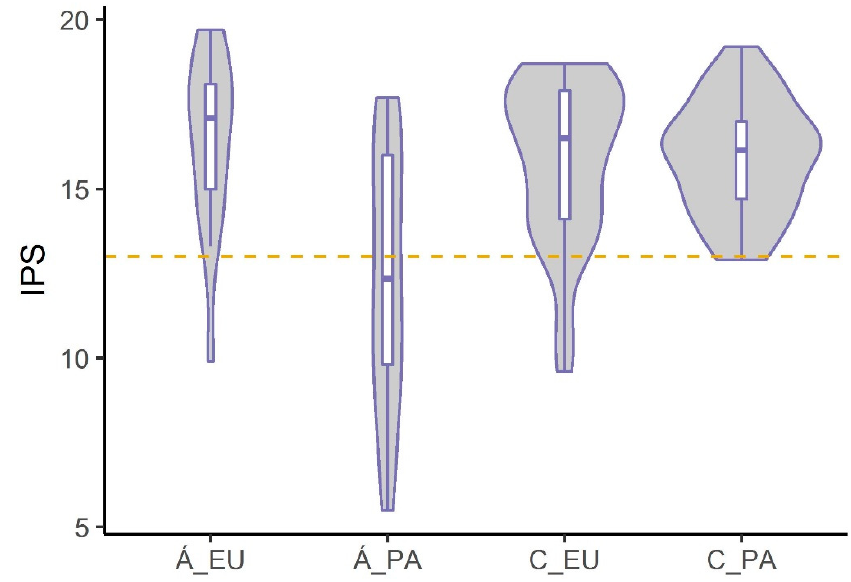
Figure 11. Violin plot of the IPS index in the eupotamic (EU) and parapotamic (PA) branches of the Ásvány (Á) and Cikola (C) tributary systems in the period of 1998–2009. Orange dashed line indicates good/moderate boundary of the index.